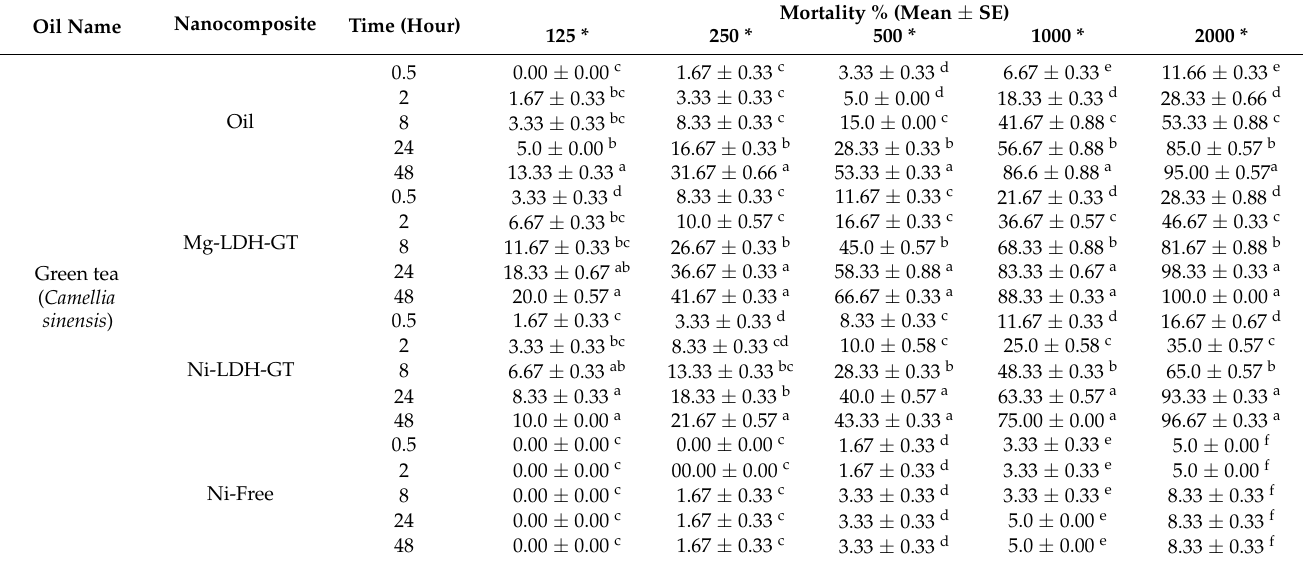
Table 3. Larvicidal effects of green tea oil and its LDH against Culex pipiens , 48 h post